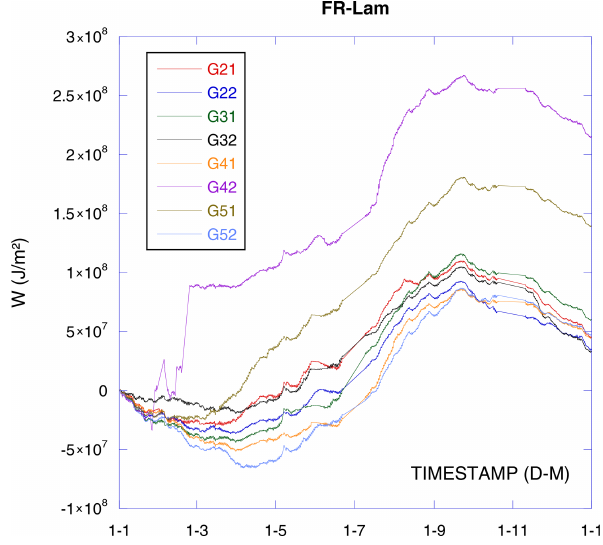
Figure 4. Integrated raw measurements of eight heat flux plates in- stalled on FR-Lam on an agricultural plot (cropland) for 1